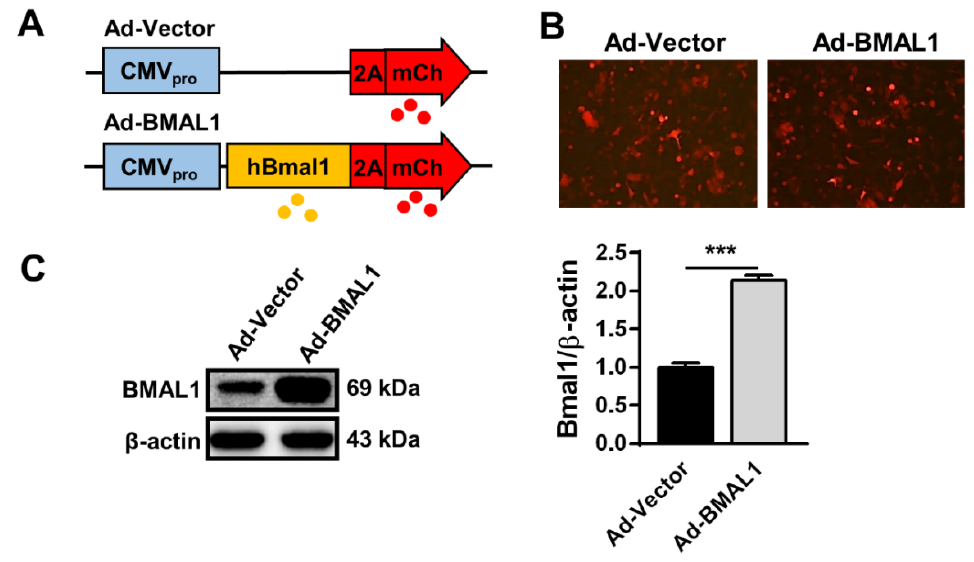
Figure 4. BMAL1 was highly expressed in U87MG cells infected with Ad-BMAL1 viruses. ( A ) Construction of Ad-vector (control) and Ad-BMAL1 (BMAL1) plasmids. ( B ) U87MG cells were infected with control and BMAL1 viruses for 48 h. Expression of mCherry was examined under the fluorescence microscope. ( C ) The cell lysates from Figure 5B were also analyzed by Western blot to